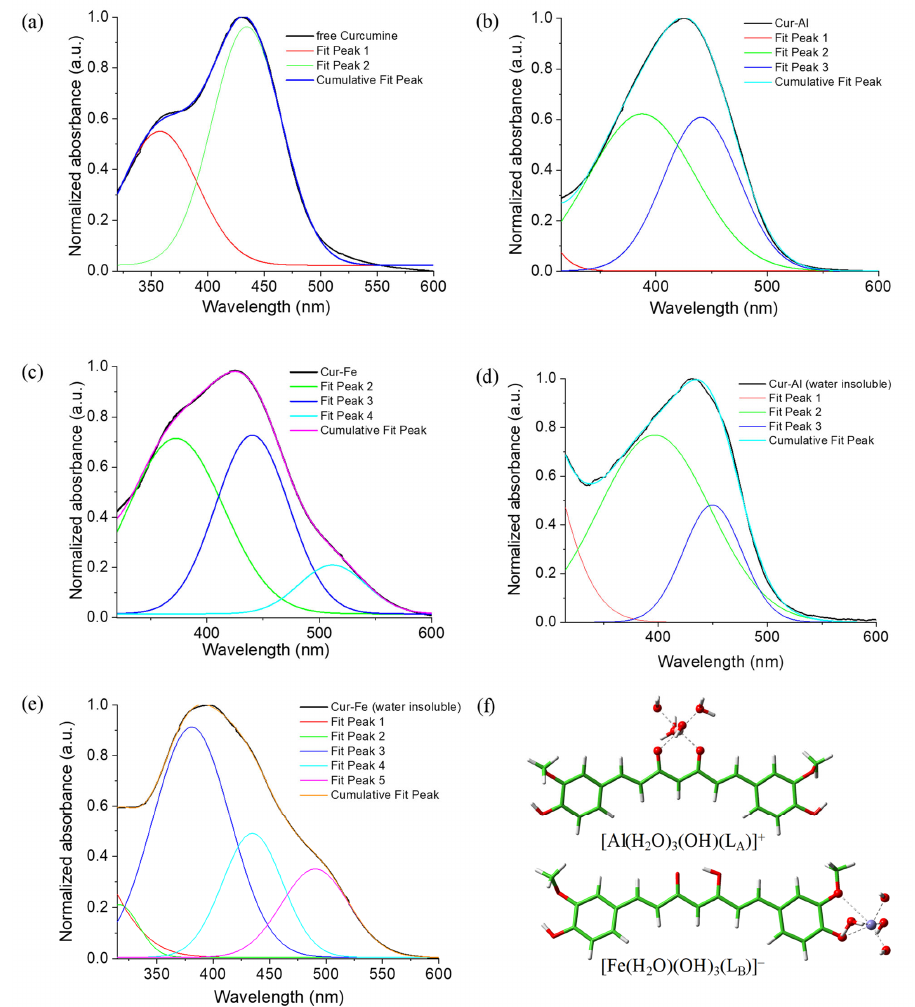
Figure 5. Deconvolution analysis of UV–Vis Spectra: ( a ) free Cur; ( b ) Al(III)–Cur aqueous solution; ( c ) Fe(III)–Cur aqueous solution; ( d ) Al(III)–Cur solid; ( e ) Fe(III)–Cur; and ( f ) optimized structures of the most probable Al– and Fe–Cur complexes. Adapted from [45], Copyright Elsevier 2019.